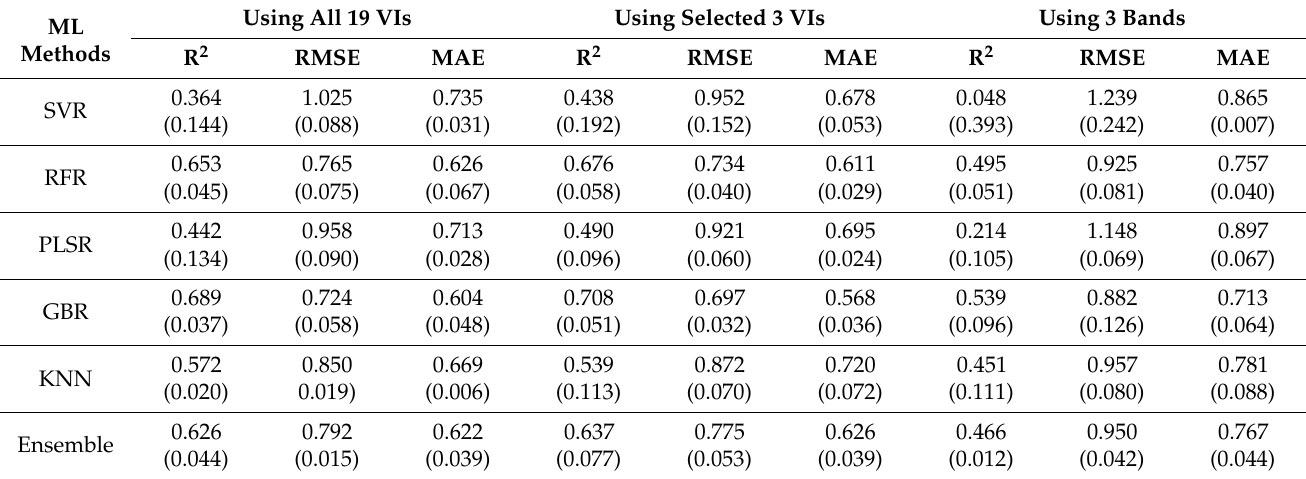
Table A3. Test accuracies including mean and standard deviation of five base models and an